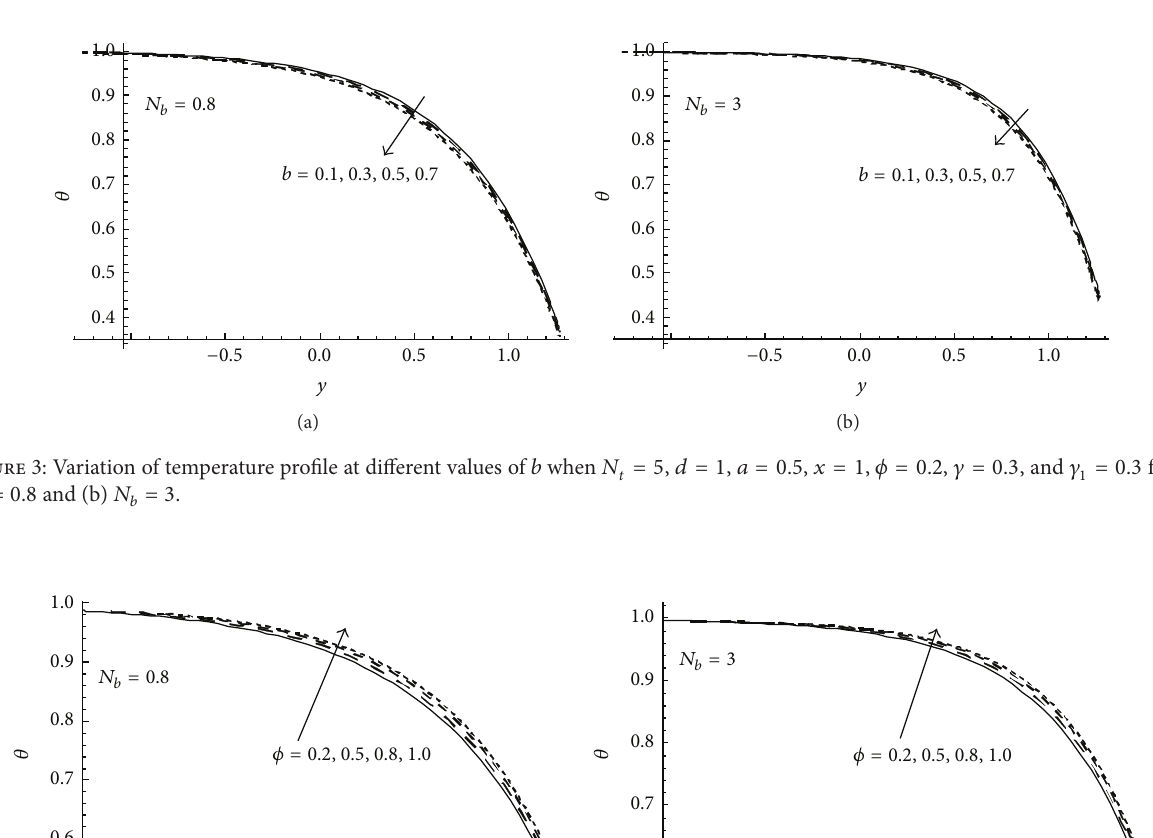
𝜙 = 0.2 , 0.5 , 0.8 , 1.0